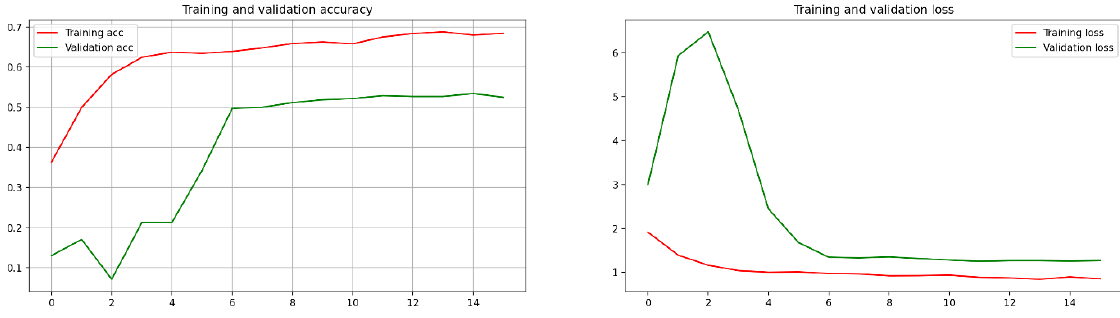
Figure 7. The plots of convergence for the comparison